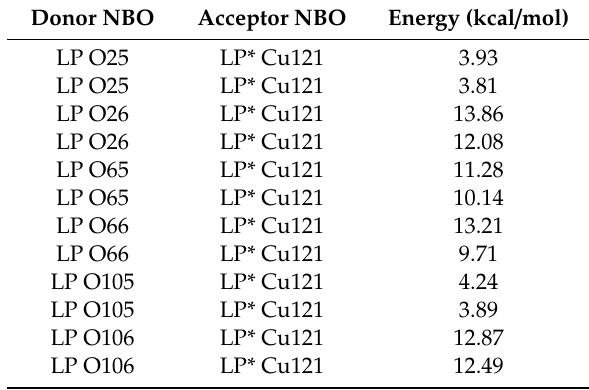
Table 2. Secondary orbital interactions for Cu 2 + / compound 1